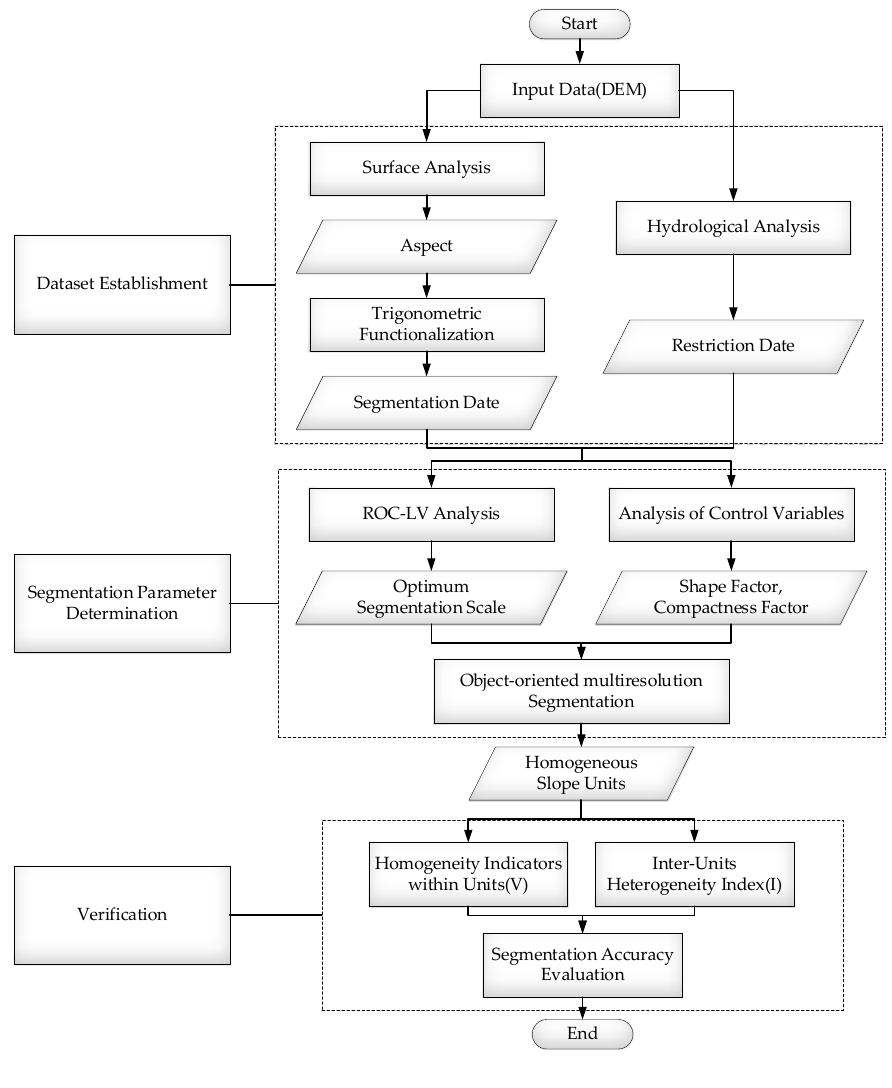
Figure 1. Flowchart for the proposed approach.